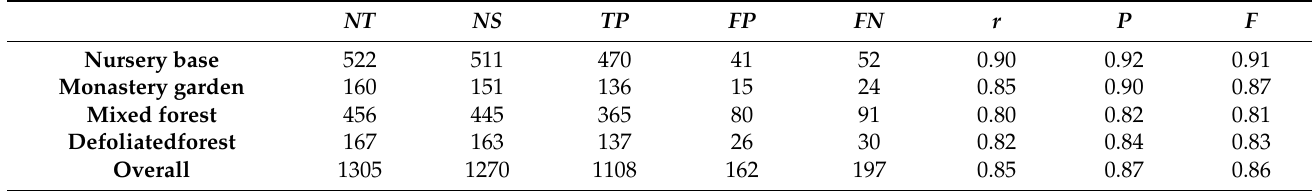
Table 3. Accuracy assessments of the individual tree segmentation on the four testing sites. NT Nursery